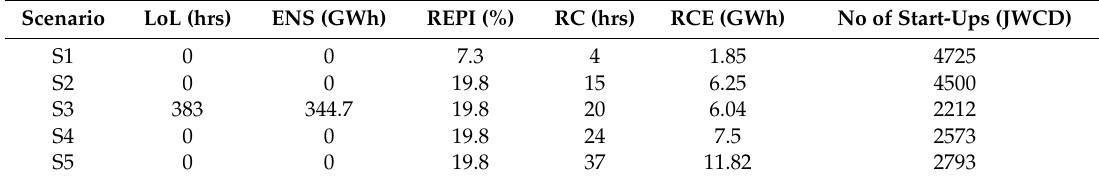
Table 8. Values of selected indicators for di ff erent